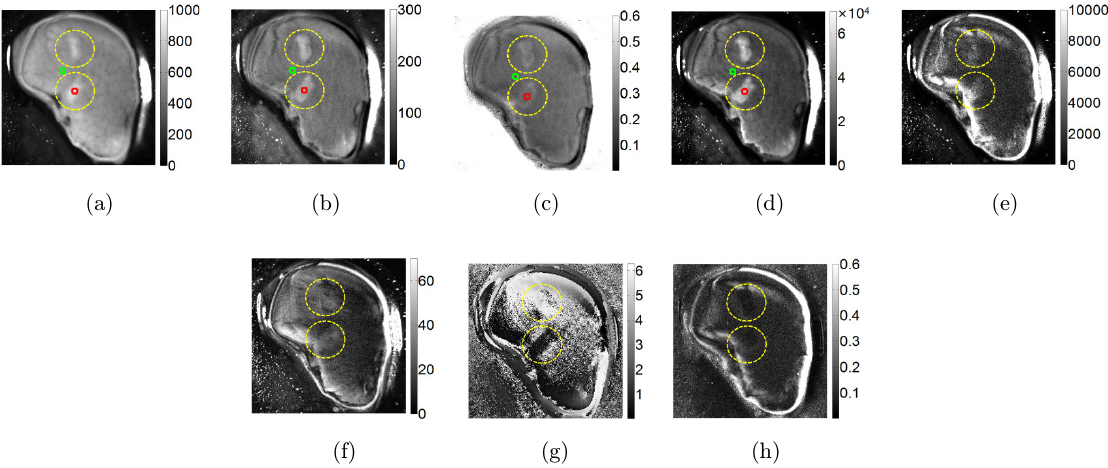
Fig. 3. Experimental results: (a) intensity, (b) DP, (c) DOP, (d) RLPI(B), (e) RLPI(A), (f) RLPI(C), (g) RLPI( ’ 3 = 2) and (h) RLPI(G), for a nude mouse's liver with metastasis of nasopharyngeal carcinoma CNE-1. The carcinoma areas are marked by yellow circle frames. Contrast between the healthy (marked as green squares) and cancerous liver tissue (marked as red squares) for intensity, DP, DOP and B are: 0.21, 0.17, 0.03 and 0.34.